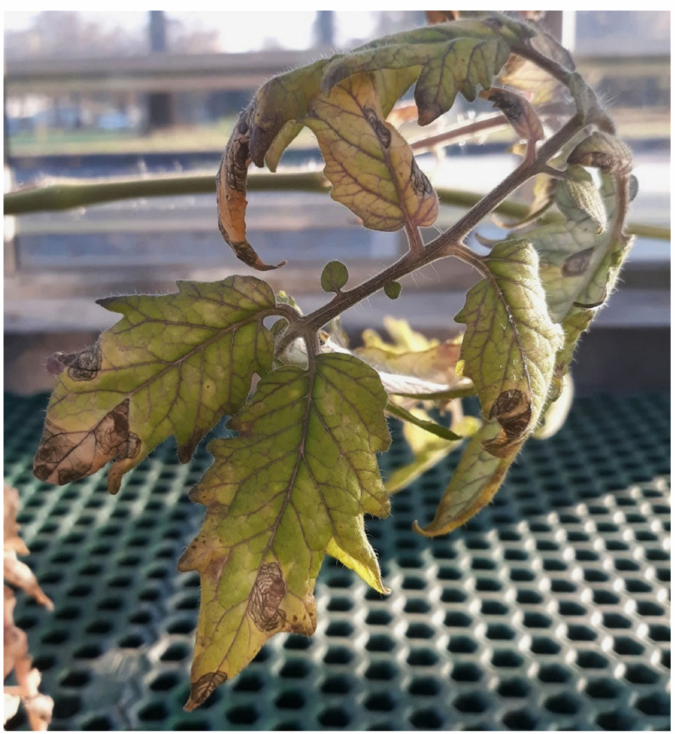
Figure 1. Early blight symptoms caused by Alternaria solani , with target-like concentric